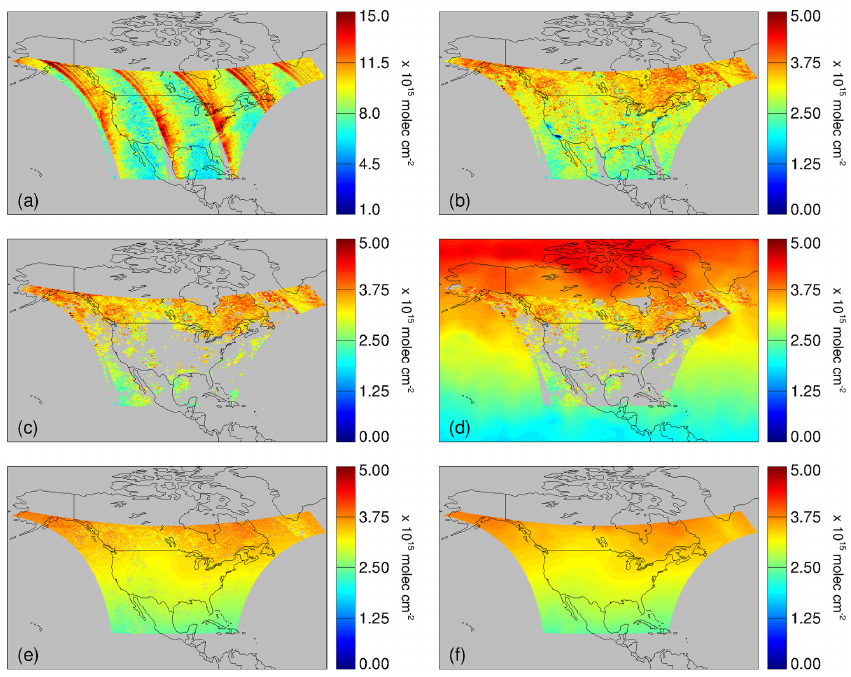
Figure 1. Calculation of the stratospheric NO 2 estimate on 15 July 2007, using OMI observations from within the anticipated TEMPO field of regard: (a) slant columns on a 0 . 1 ◦ × 0 . 1 ◦ grid. (b) Initial stratospheric estimate ( V init ) resulting from Eqs. (1) and (2). (c) Masked V init using a threshold of S trop /A strat < 0 . 3 × 10 15 moleculescm − 2 to remove large tropospheric influence. (d) Adding context outside of the TEMPO field of regard by using independent low-Earth-orbit observations from GOME-2 that have been corrected for time of day. (e) Stratospheric NO 2 estimate with masked areas interpolated. (f) Stratospheric NO 2 estimate after final hot spot removal and smoothing.